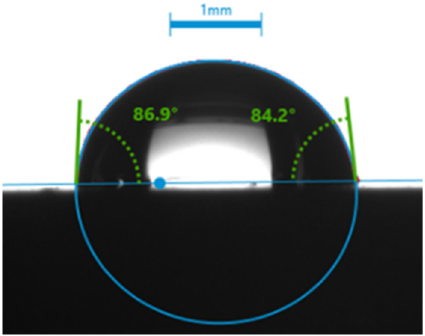
Figure 2. Photograph of liquid droplet shape analysis.